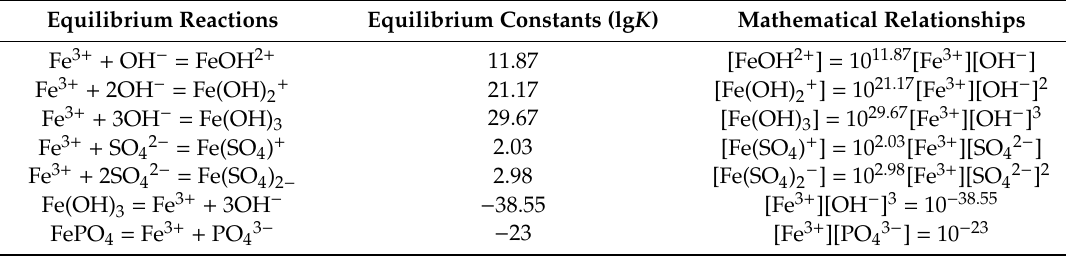
Table 3. Chemical equations and expanded forms in the system